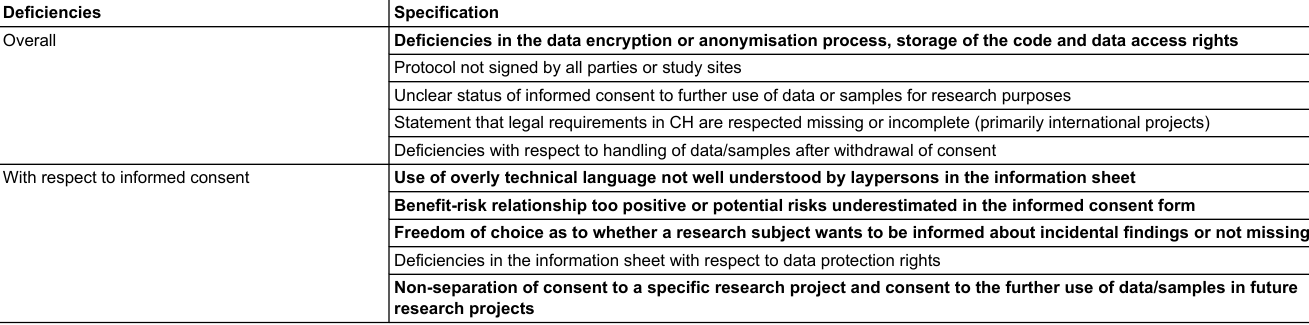
Table 2: Frequencies of modifications requested by the ethics committee regarding parent/patient information or the consent form from a total of 74 submissions. Parent/patient information